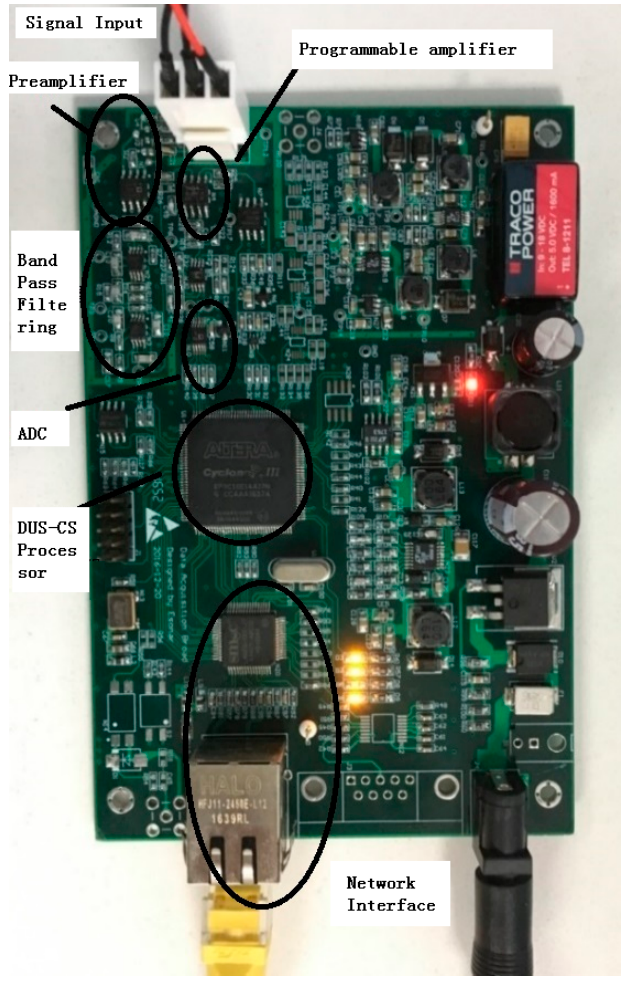
Figure 8. Photograph of the collection card.